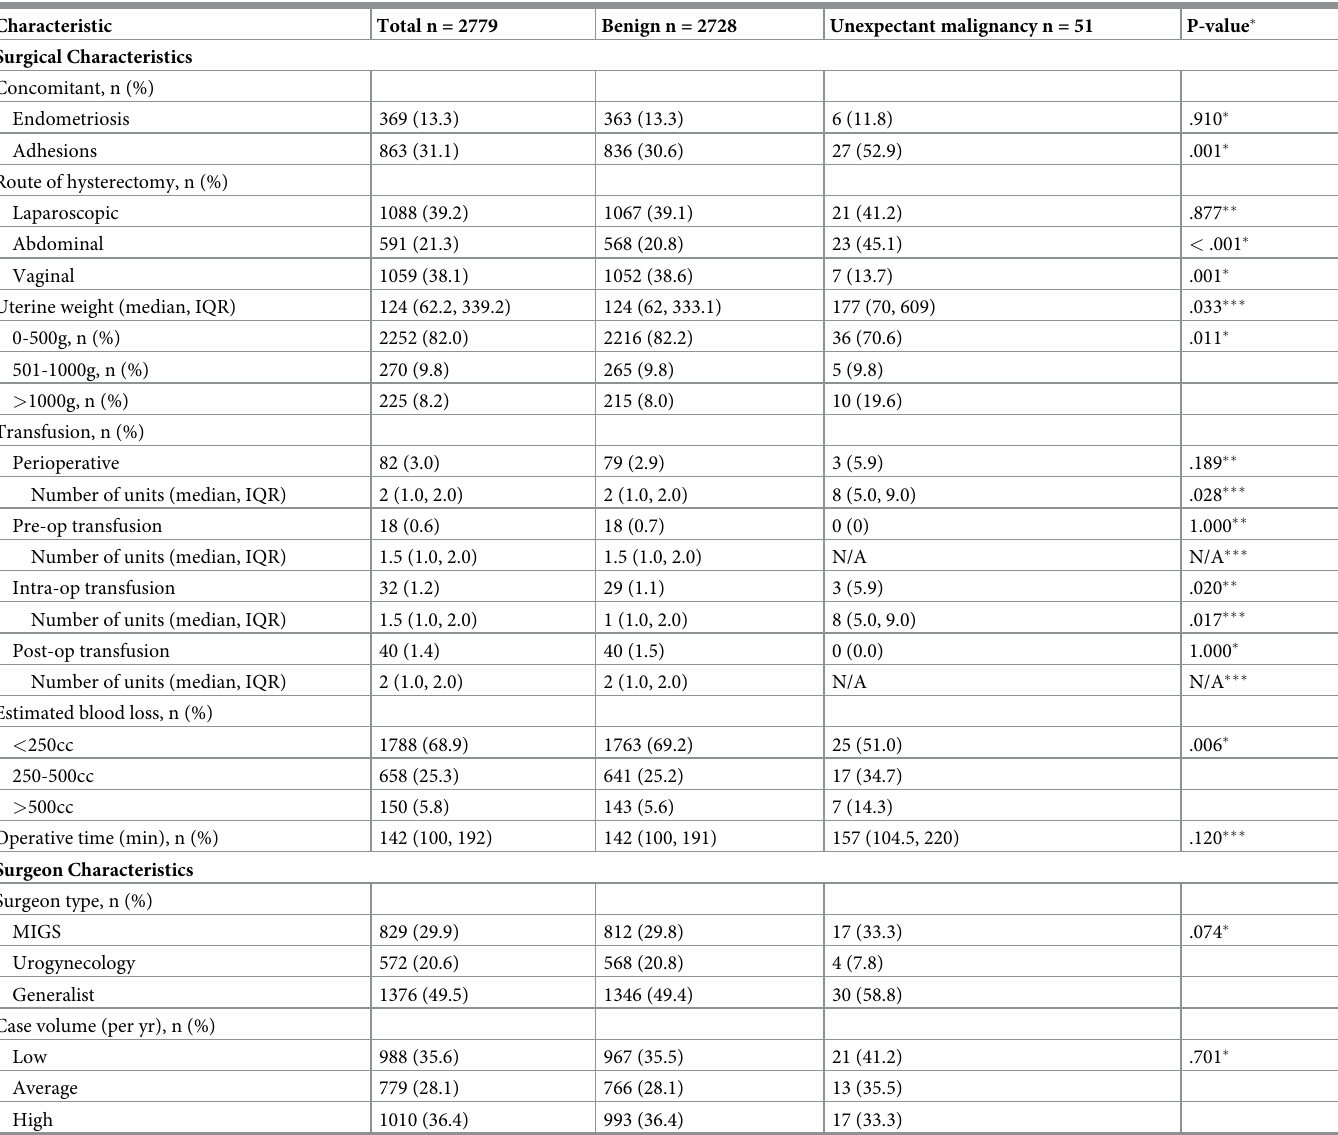
Table 3. Surgical and surgeon characteristics of patients with benign and unexpected malignant